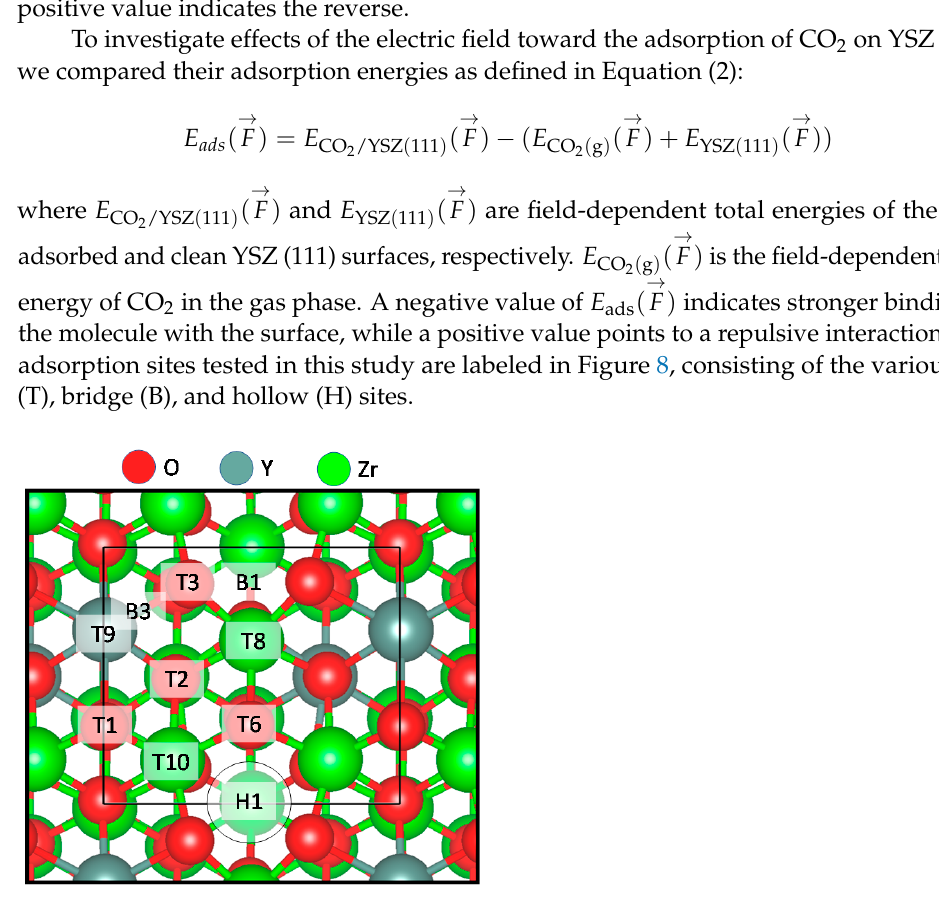
Figure 8. Initial CO 2 adsorption sites that were tested on the (1 × 1) YSZ (111) cell.